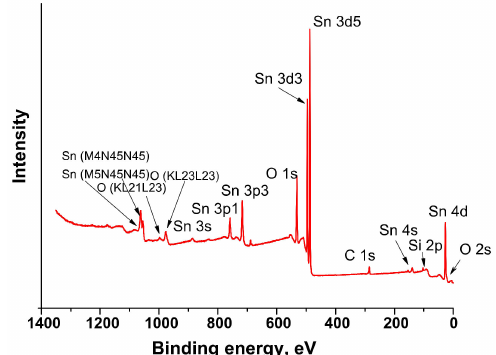
Figure 8. Survey X-ray photoelectron spectra of SnSi13 sample.